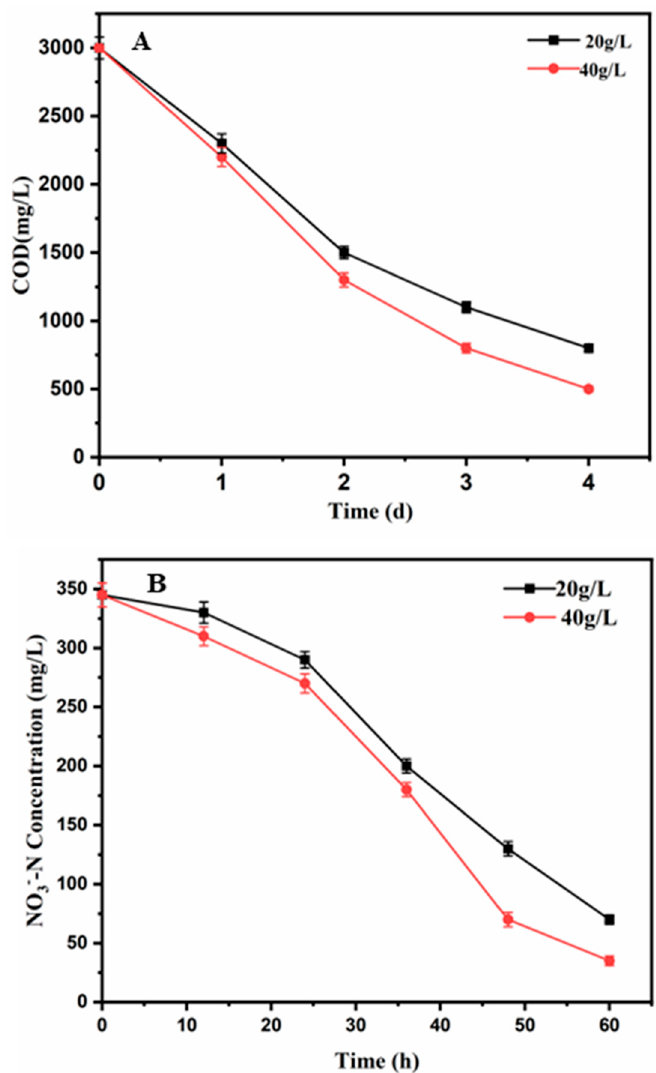
Figure 4. ( A ) Chemical oxygen demand (COD) degradation profile with time at different salinities, ( B ) Nitrate-nitrogen removal profile with time at different salinities.